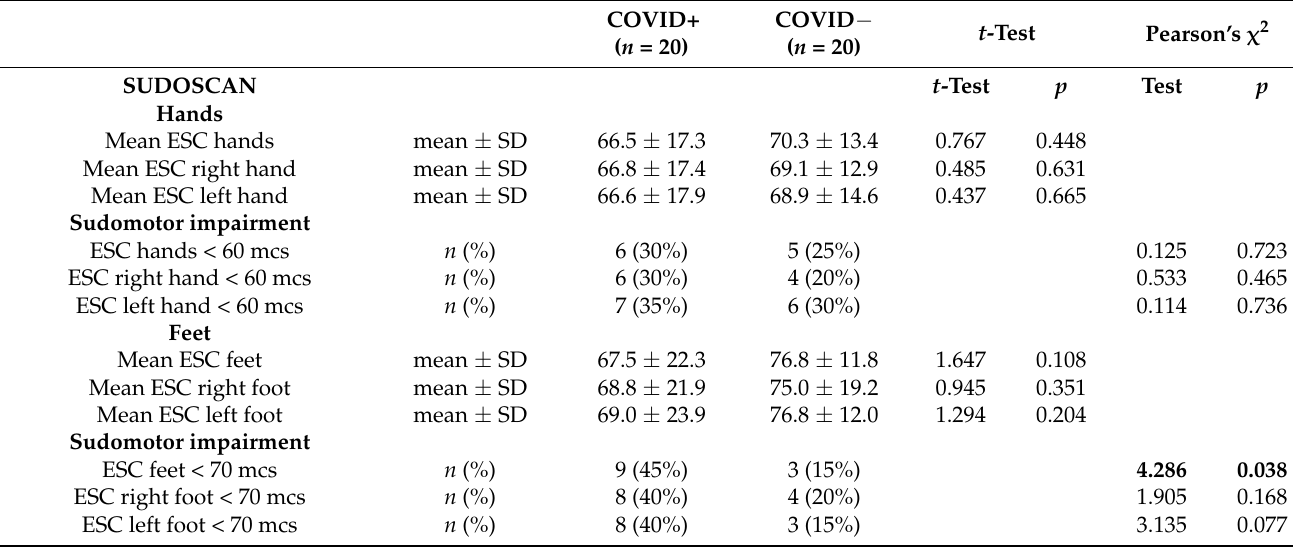
Table 4. Results of Sudoscan analysis. Categorical variables are expressed as number ( n ) and percentage (%), and numerical variables as mean ± SD, since they were normally distributed. For categorical variables, we adopted the Pearson’s χ 2 test. Numerical variables were analyzed by means of t -test. Significance was set at p < 0.05. We can see highlighted the results that reached statistical